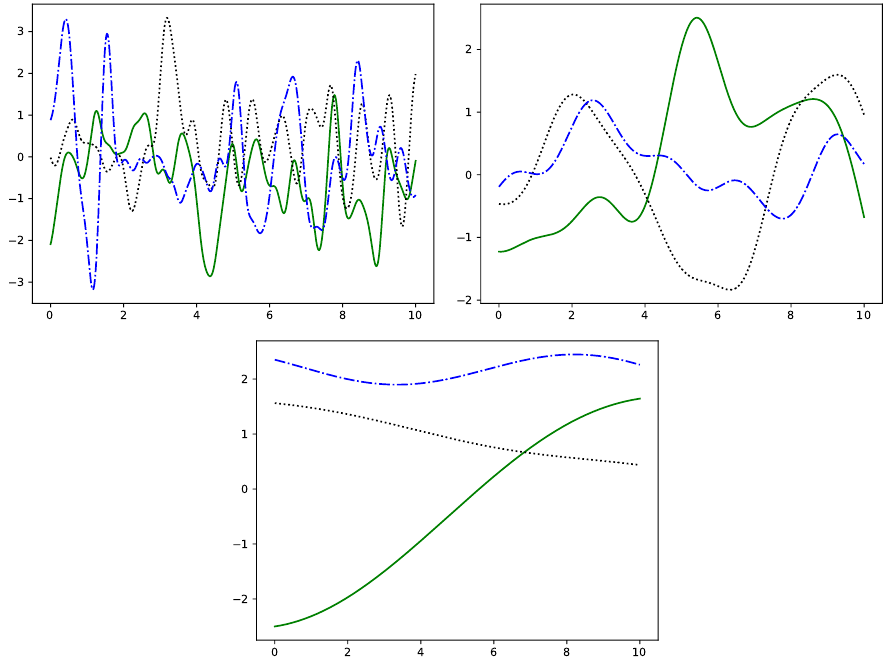
Figure 2. Samples drawn from a squared exponential kernel GP with length-scale (cid:96) = 0.1 ( left ), 1.0 ( right ) and 10.0 ( bottom